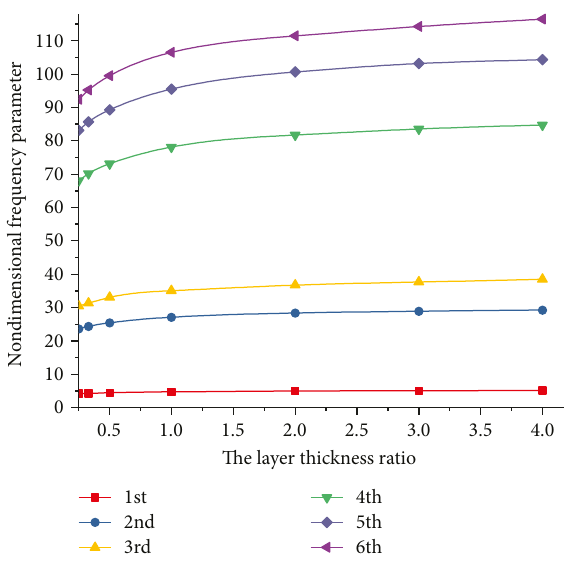
Figure 10: Variations of nondimensional frequency parameters with the layer thickness ratio ( l = 3 , h = 20 , n = 2 , and θ = 30 °